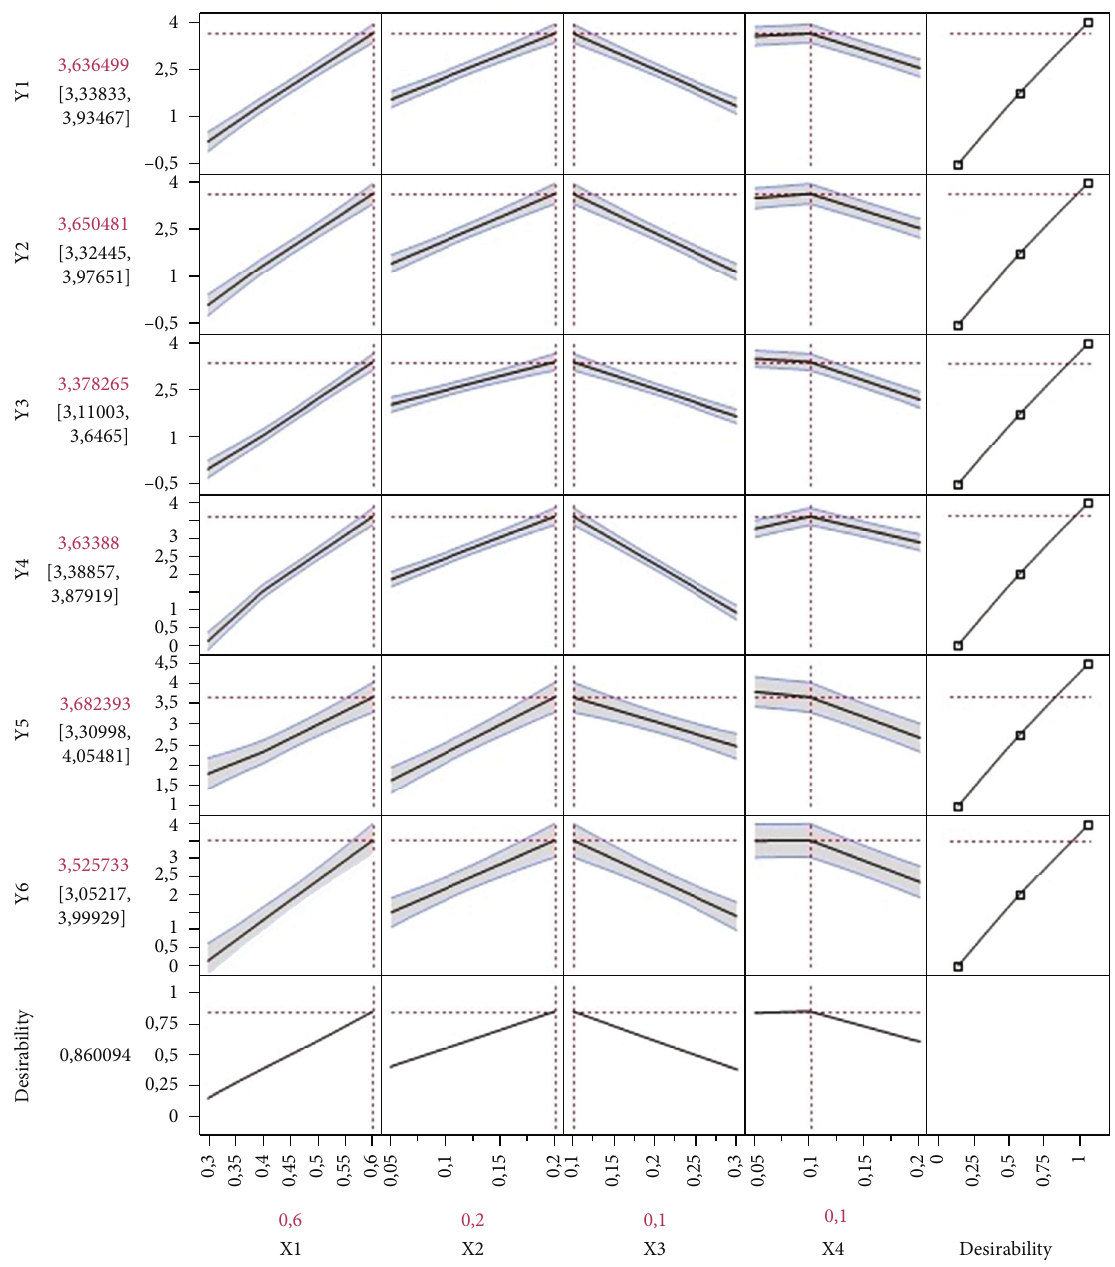
Figure 3: Maximum desirability in pro fi ler for mixture